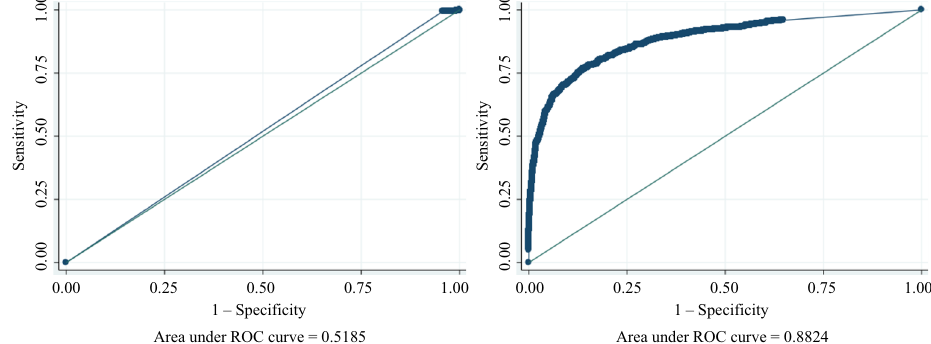
Fig. 2. ROC curves for univariate Probit